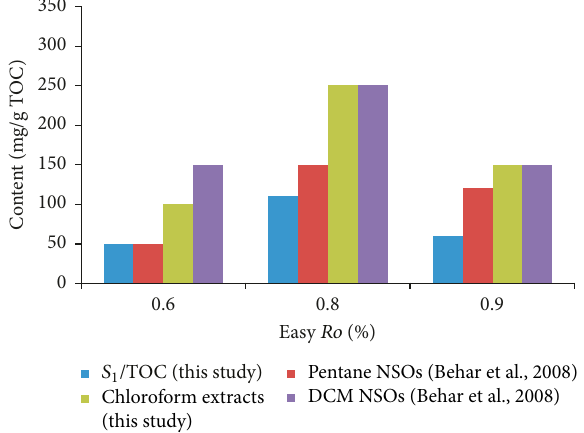
Figure 2: Relationships between Rock-Eval 𝑆 1 , chloroform extracts, and soluble organic